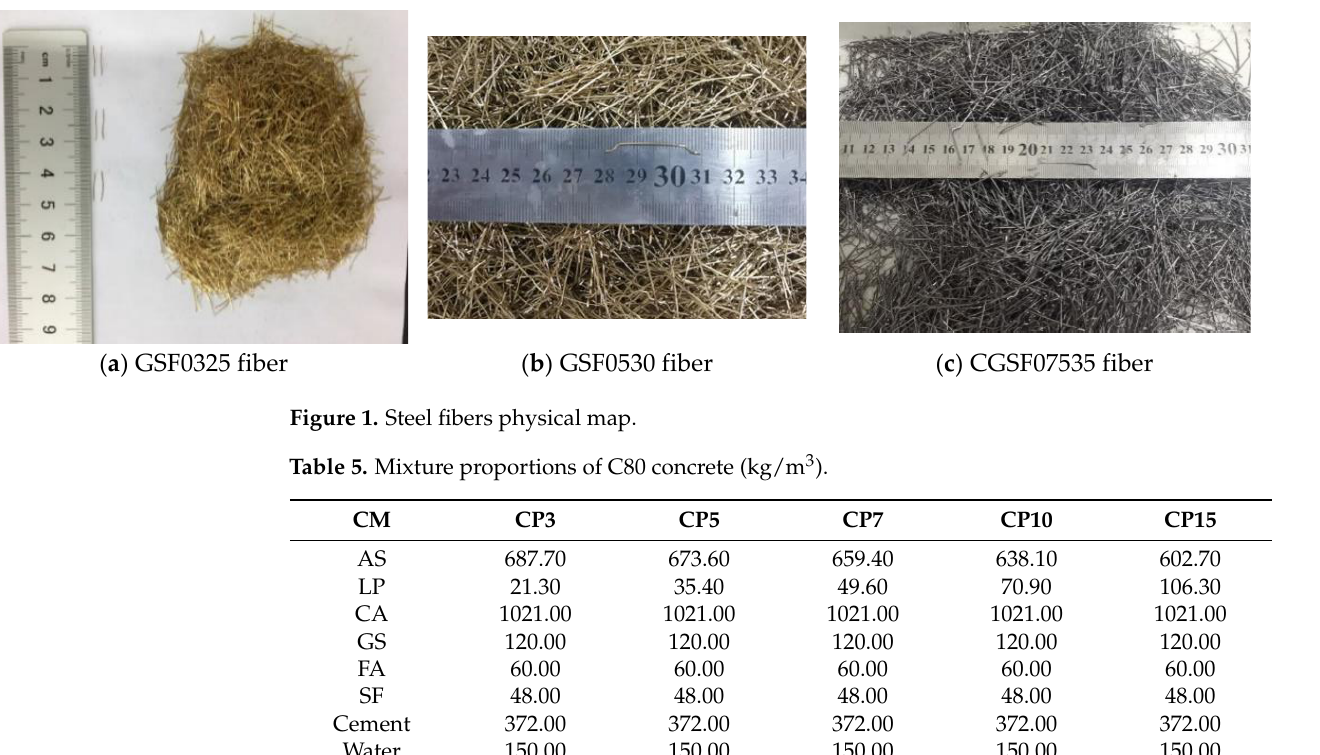
Table 3. Chemical components of OPC, GS, FA and SF by wt.%.